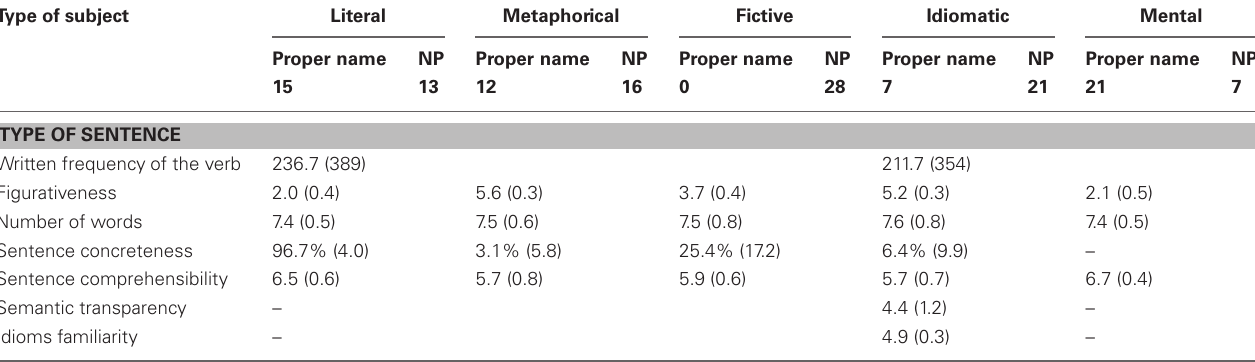
Table 1 | Mean concreteness, written frequency, comprehensibility of the sentences, familiarity and semantic transparency of the idioms. Type of